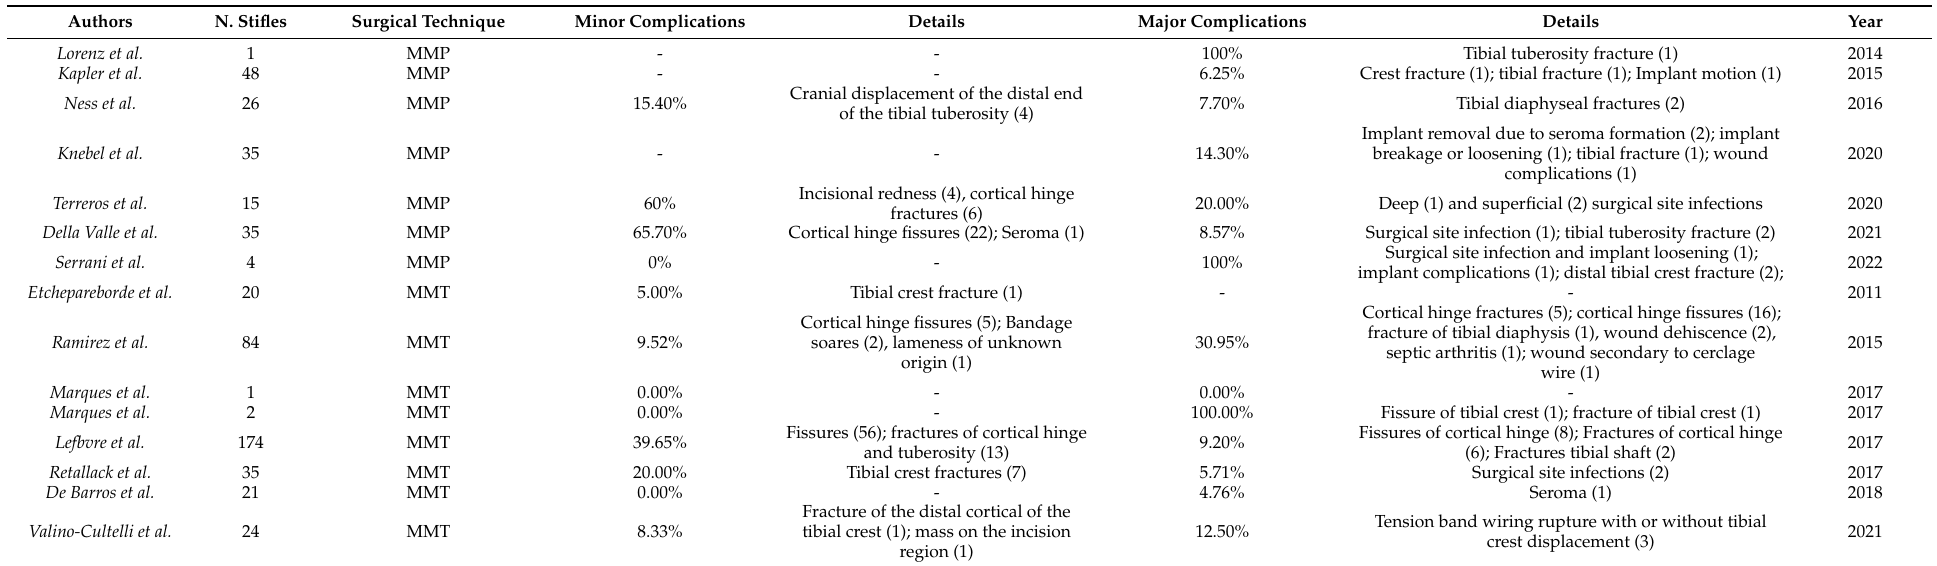
Table 3. Complications are expressed in percentage and in detail for papers